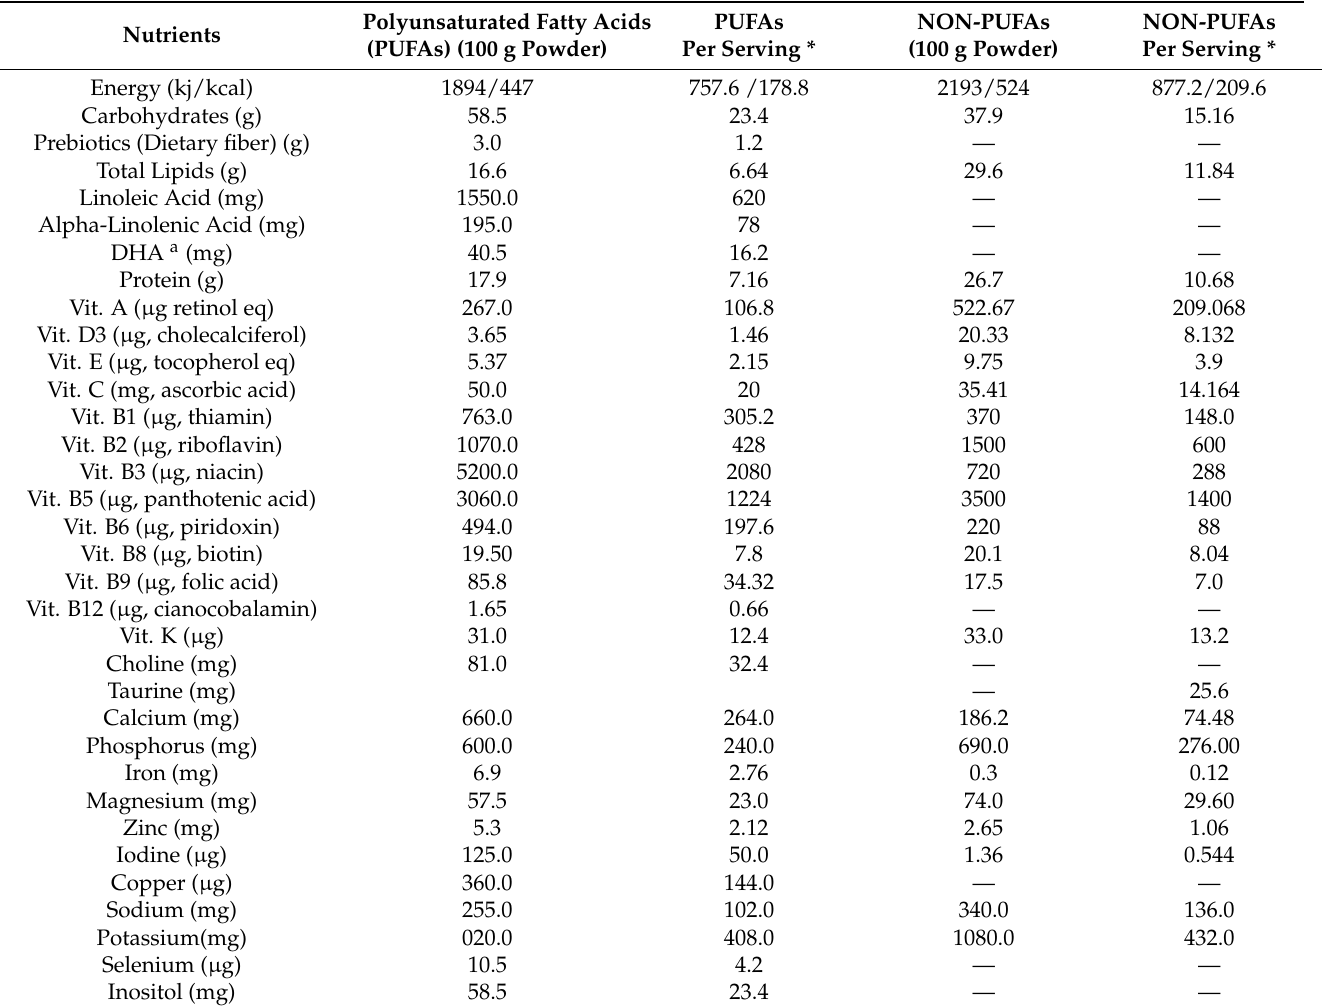
Table 1. Nutrient composition of study formulas by treatment